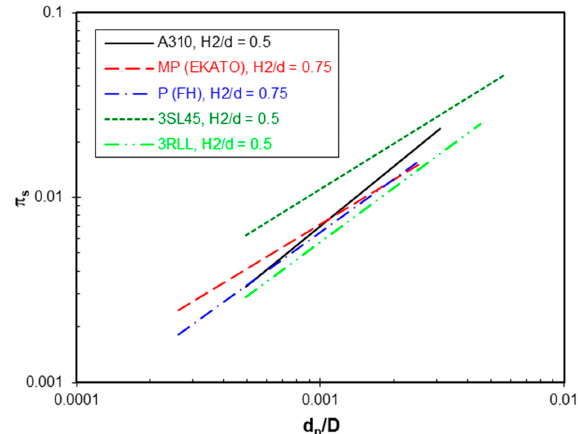
Figure 12. Dependence of the dimensionless power required to achieve the just-suspended state of particles of axial flow impellers on the dimensionless particle diameter d p / D for the mean volumetric concentration of the solid phase c v = 10% [28]. Processes 2020 , 8 , x FOR PEER REVIEW